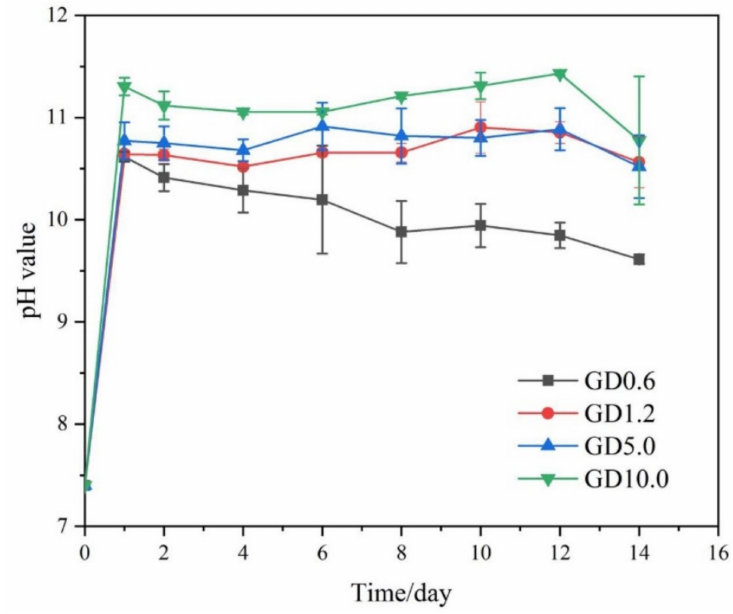
Figure 7. pH monitoring of as-extruded Mg–Gd–Dy–Zr alloys during the in vitro immersion